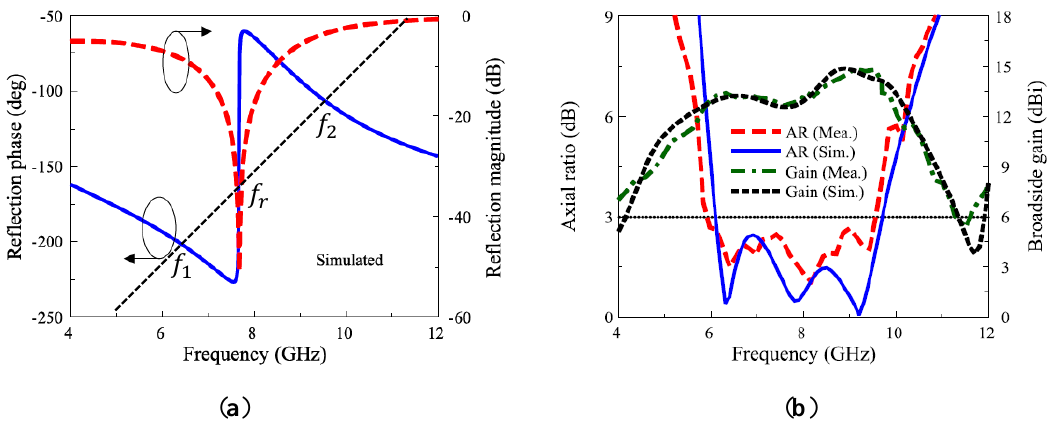
Figure 4. ( a ) Reflection phase and magnitude of the PRS unit cell; ( b ) AR and gain.